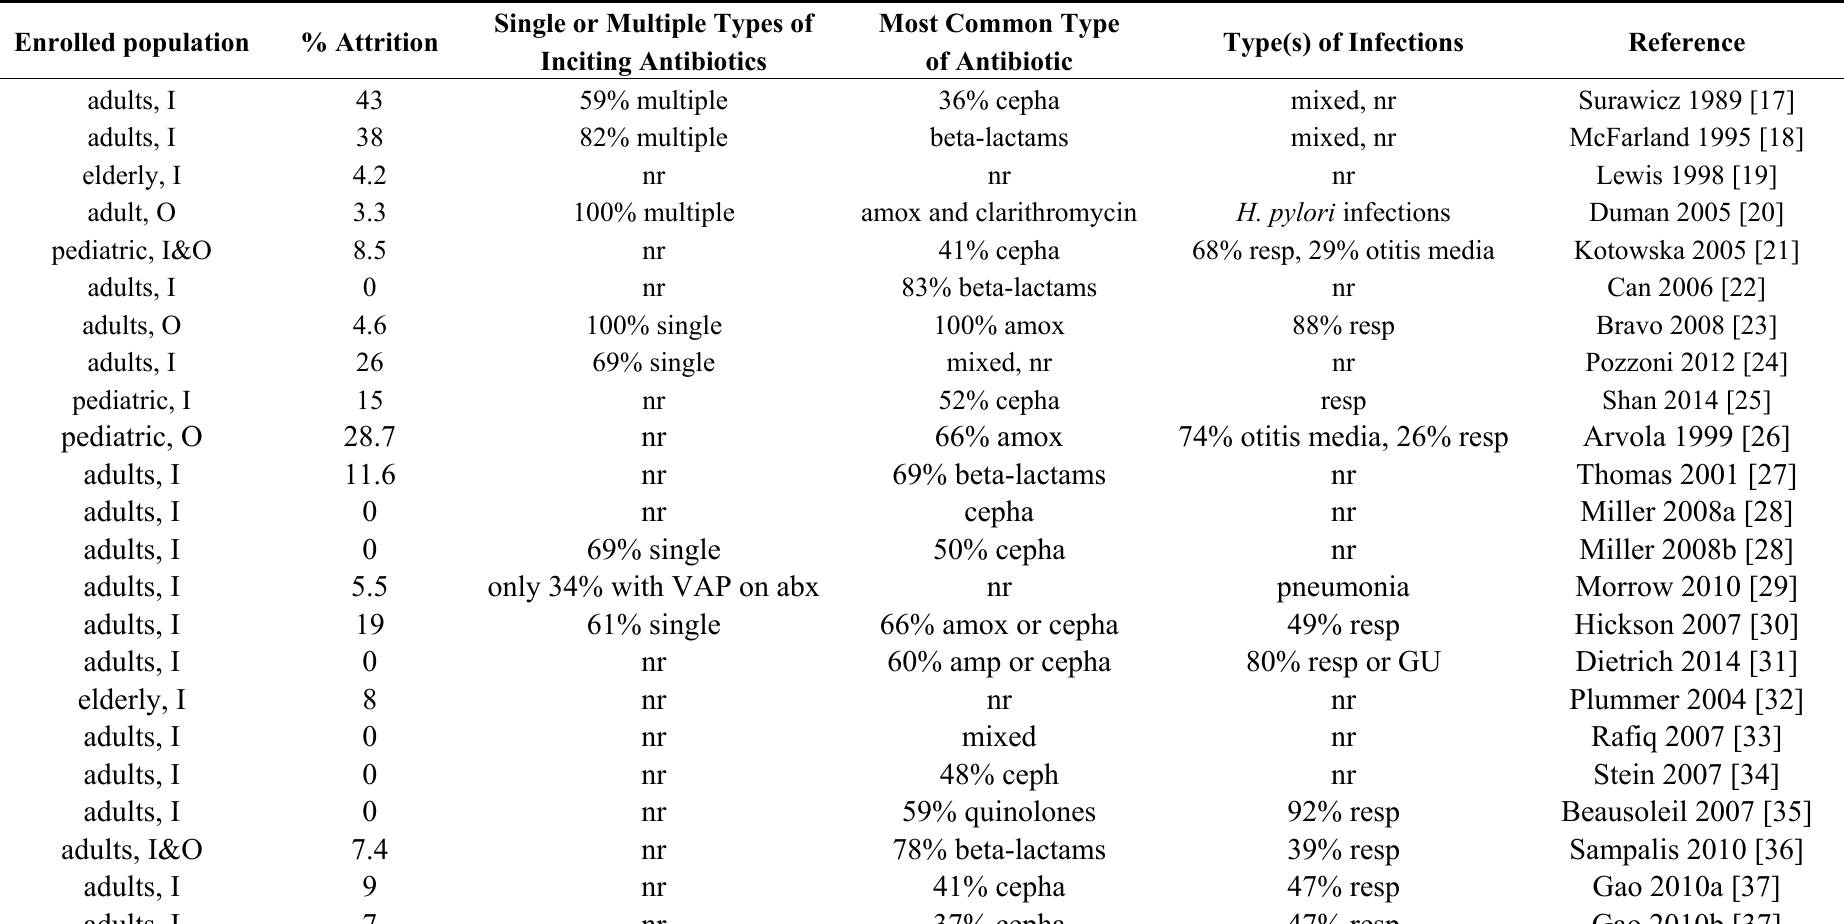
Table 2. Study design description for primary prevention of C. difficile infections from studies of Probiotics for the Prevention of Antibiotic-associated